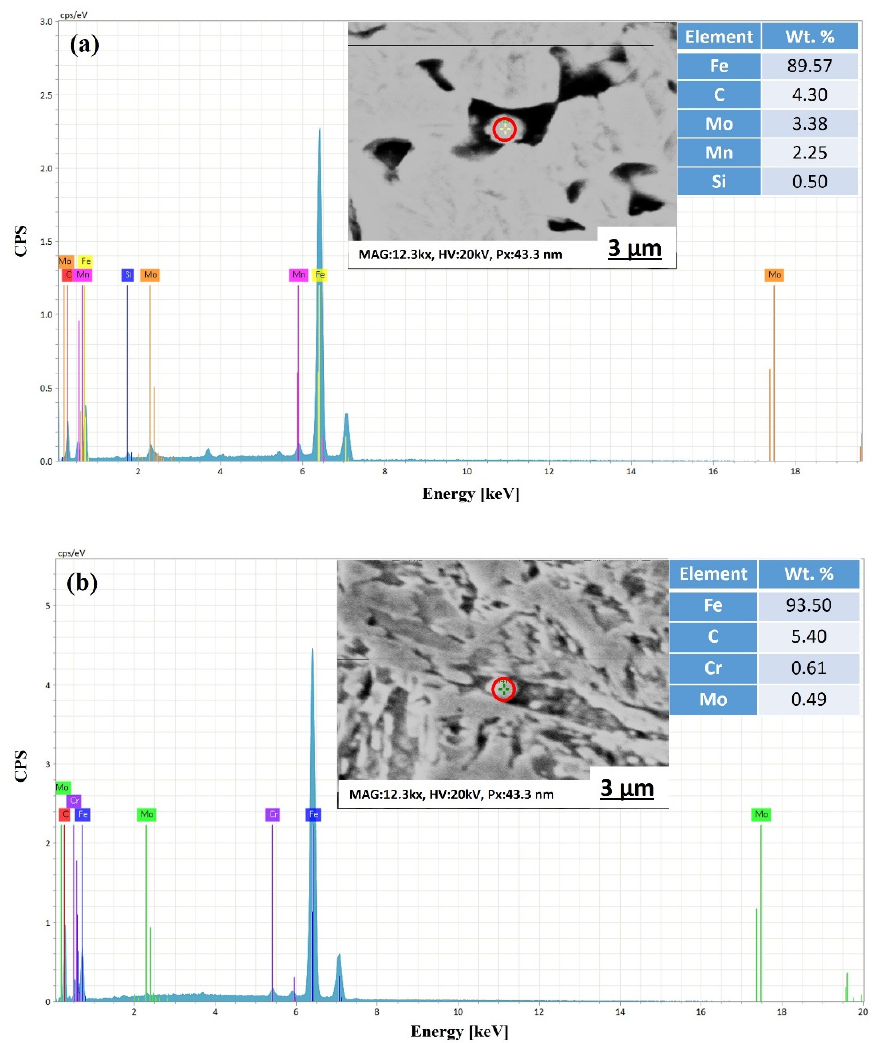
Figure 3. EDS spectra of LT samples at different locations, i.e., ( a , b ). Precipitates were measured using point scanning.